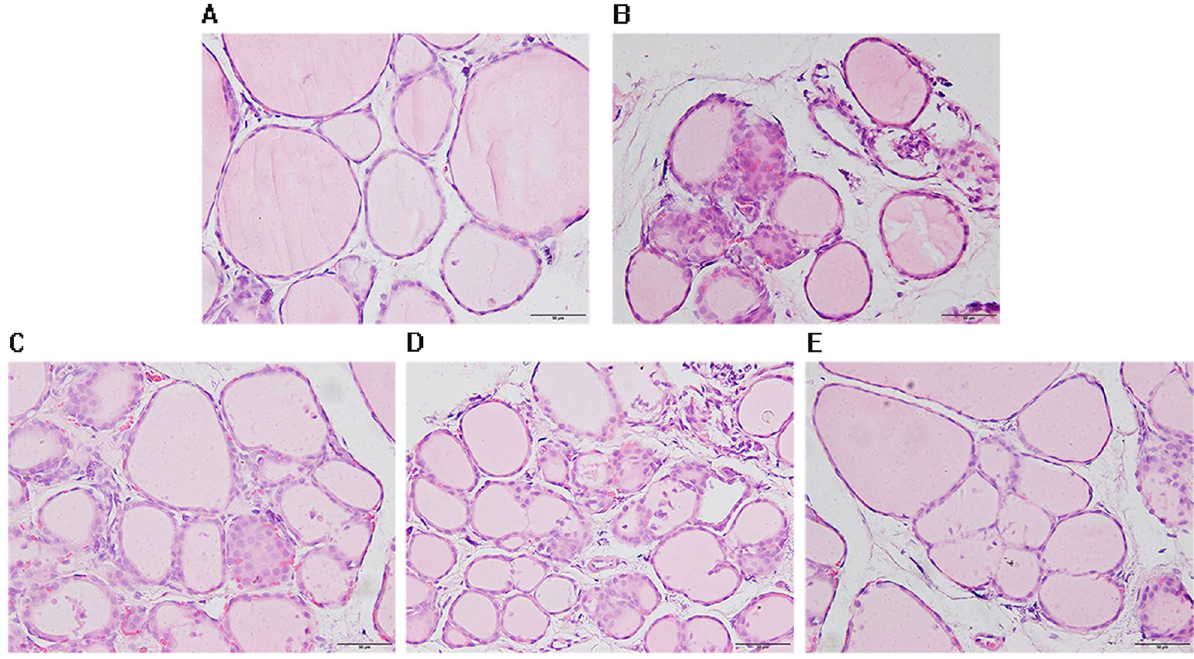
Figure 1. Light microscopic observation results of H&E staining of rat thyroid (× 200). ( A ) Normal group, ( B ) AIT-model group, ( C ) Diosgenin-L group, ( D ) Diosgenin-M group, ( E ): Diosgenin-H